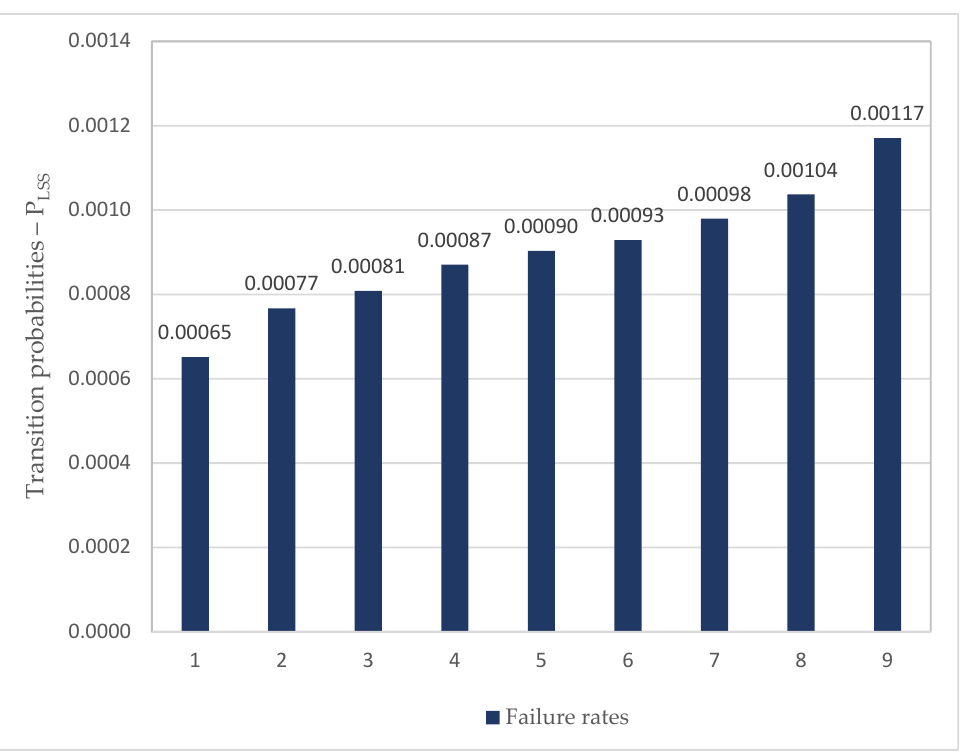
Figure 4. Dependence of the P TSS values on the failure rates λ CSS, λ TSS, and λ LSS acc. to Figure 2, for the constant µ TSS = 1.0399 d −1 and µ LSS = 0.0276 d −1 .